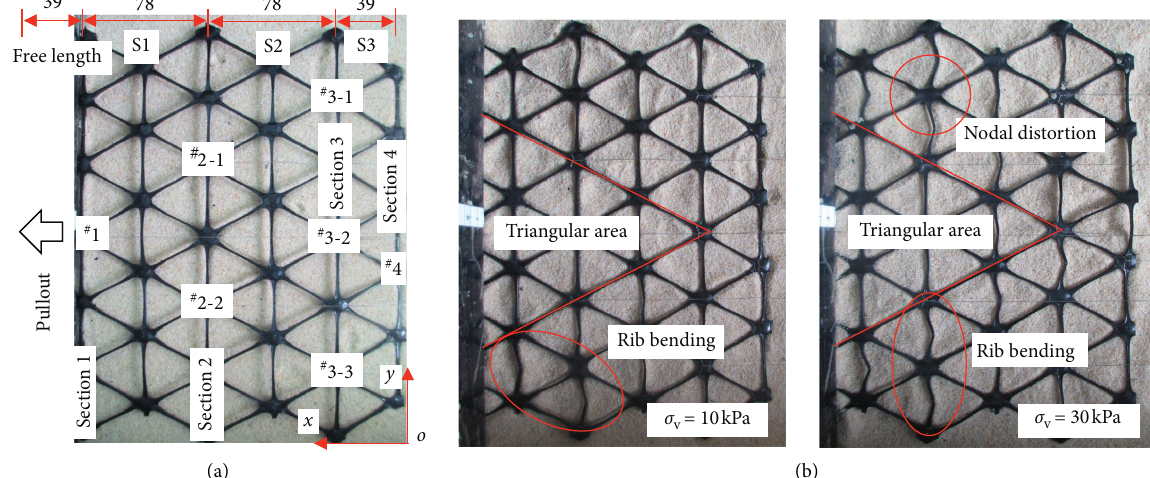
Figure 5: Layout of measuring positions and geometry deformation after pullout test. (a) Layout of measuring points and sections (unit: mm), (b) Geometry deformation after pullout